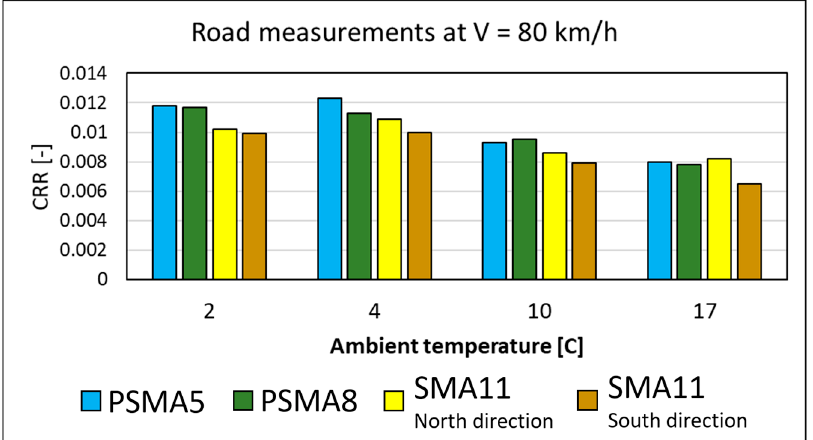
Figure 33. Coefficients of rolling resistance measured on the road at 80 km/h at different ambient temperatures.